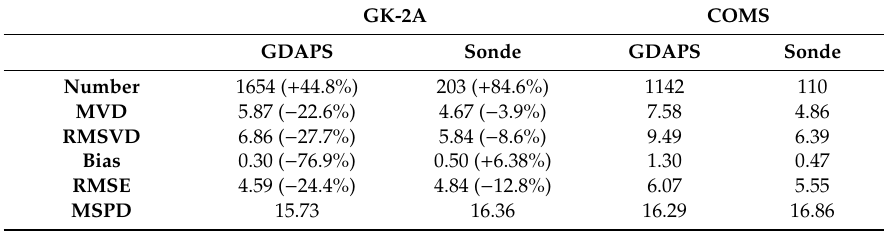
Table 4. Comparisons of validation scores of GK-2A and COMS AMVs with GDAPS and rawinsonde for the specific case of Typhoon Nepartak at 00:00 UTC on 7 July 2016, considering QIF > 80. GK-2A AMVs are approximately 64.7% more and 18.9% better than COMS AMV during this severe weather. The numbers in parentheses of GK-2A AMVs represent the amount of di ff erence compared to those of COMS